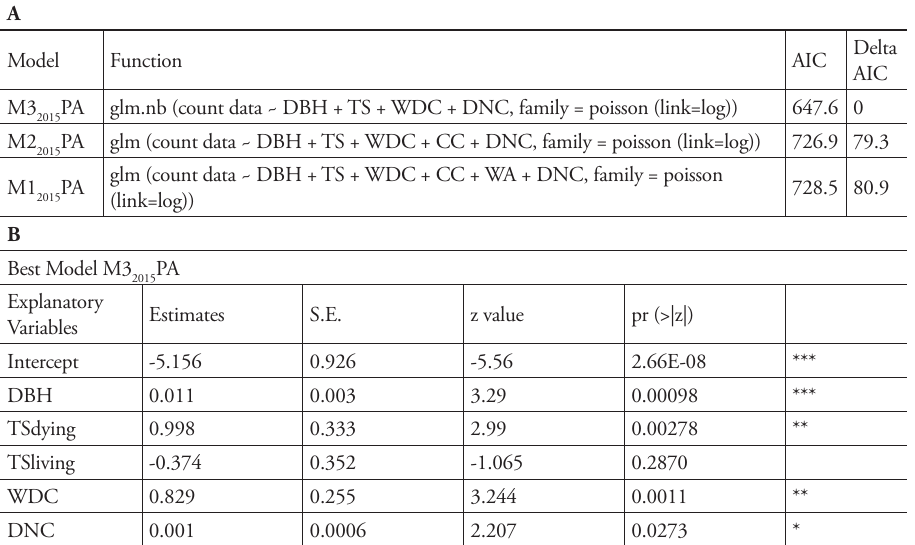
Table 6. Generalised Linear Models results. A ) Explanatory variables selection and final best model for count data for R. alpina in PA in 2015. For each model are reported the function used to build the model, AIC value and Delta AIC for selecting the best model, B ) Estimates and standard error (S.E.) of the four explanatory variables of the best model; significant codes: 0 ‘***’, 0.001 ‘**’, 0.01‘*’, 0.05